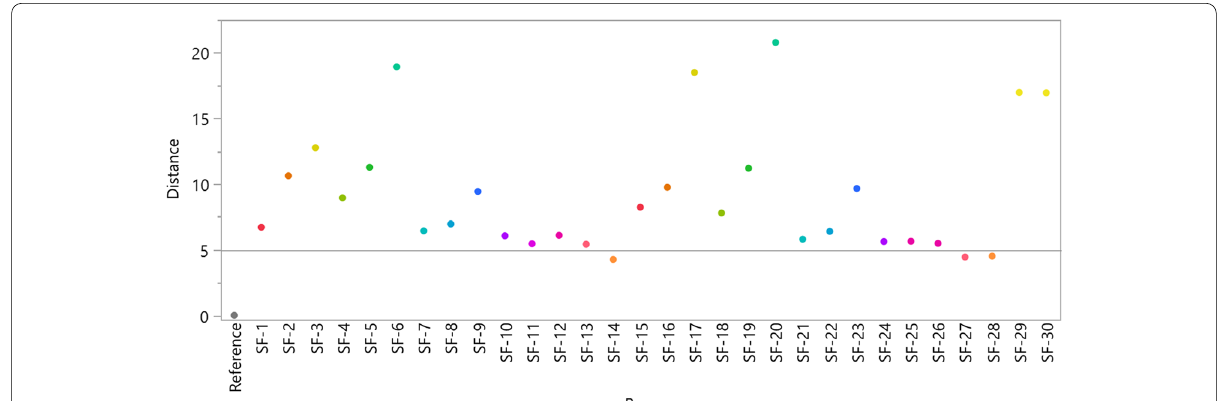
Fig. 3 Euclidean distance of 30 antibody candidates to the reference. The dot color is the same as the color in the hierarchical clustering tree for the same samples. A shorter distance means more similar to the reference